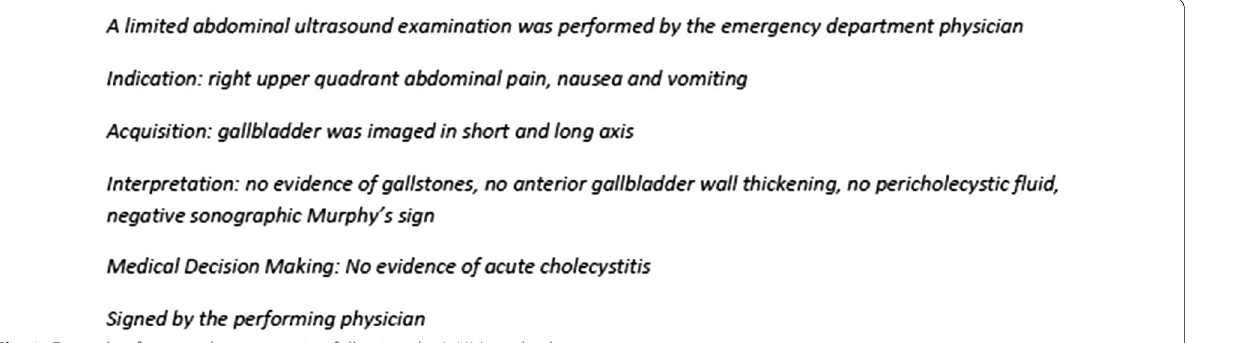
Fig. 3 Example of proper documentation following the I-AIM